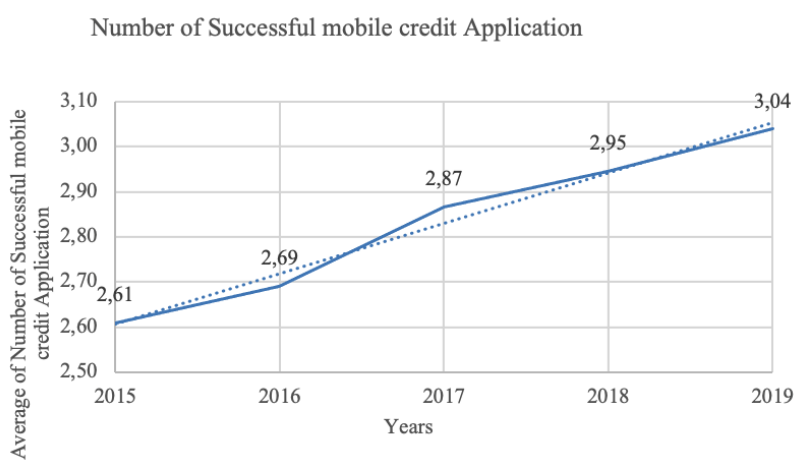
Figure 2: Trend of Number of Successful Mobile credit Applications; Source: Survey data